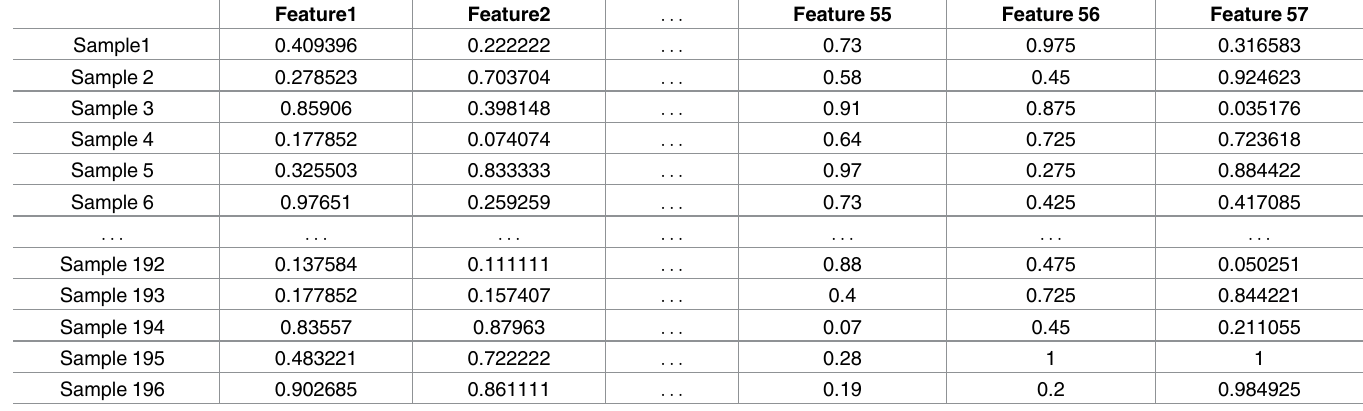
Table 3. The normalization of all the